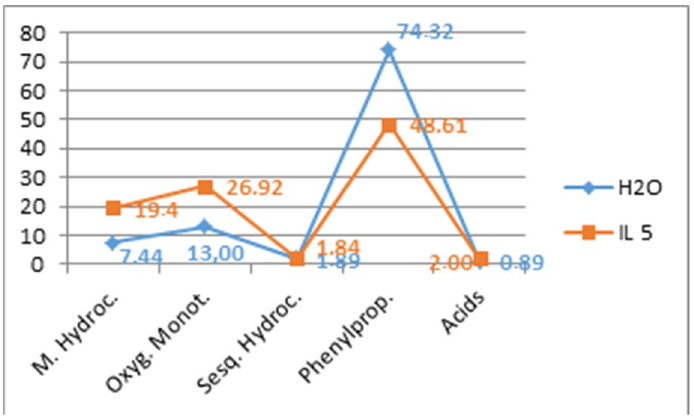
Figure 6. Comparison of essential oil composition extracted by water (blue) and by water–IL 5 (orange).